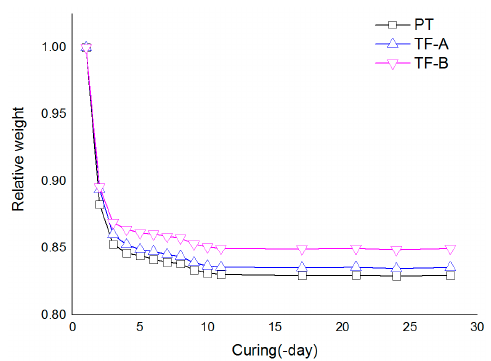
Figure 5. Relative weight changing during curing.